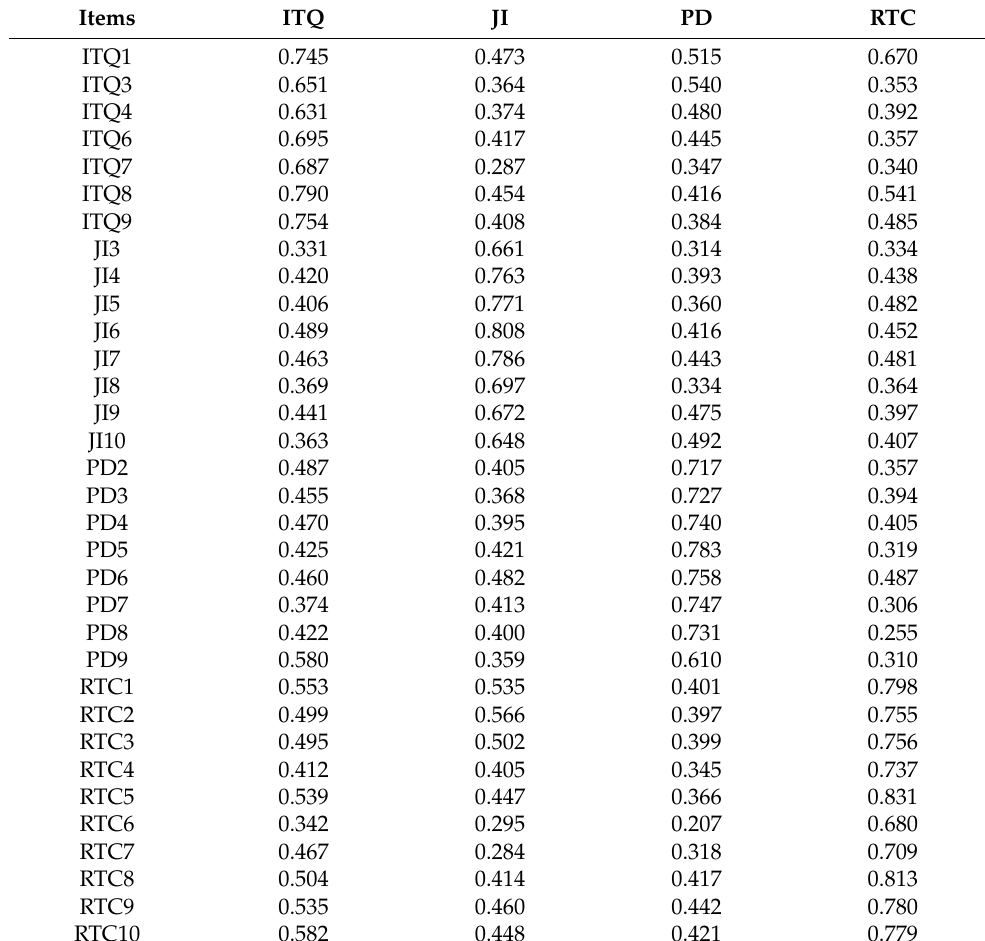
Table 4. Cross-loadings.